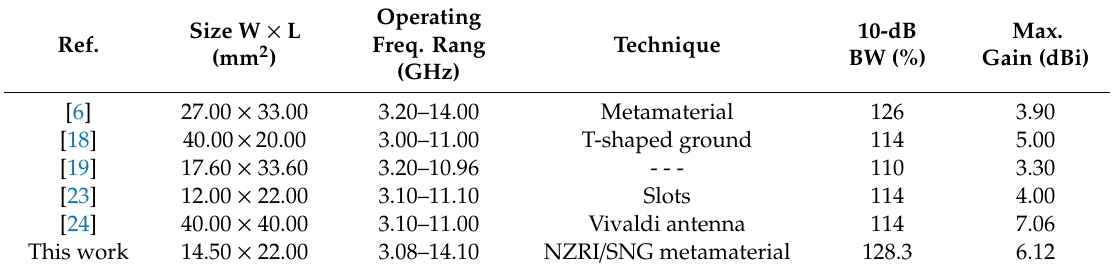
Table 1. Comparison of the designed antenna with others in the state of art.